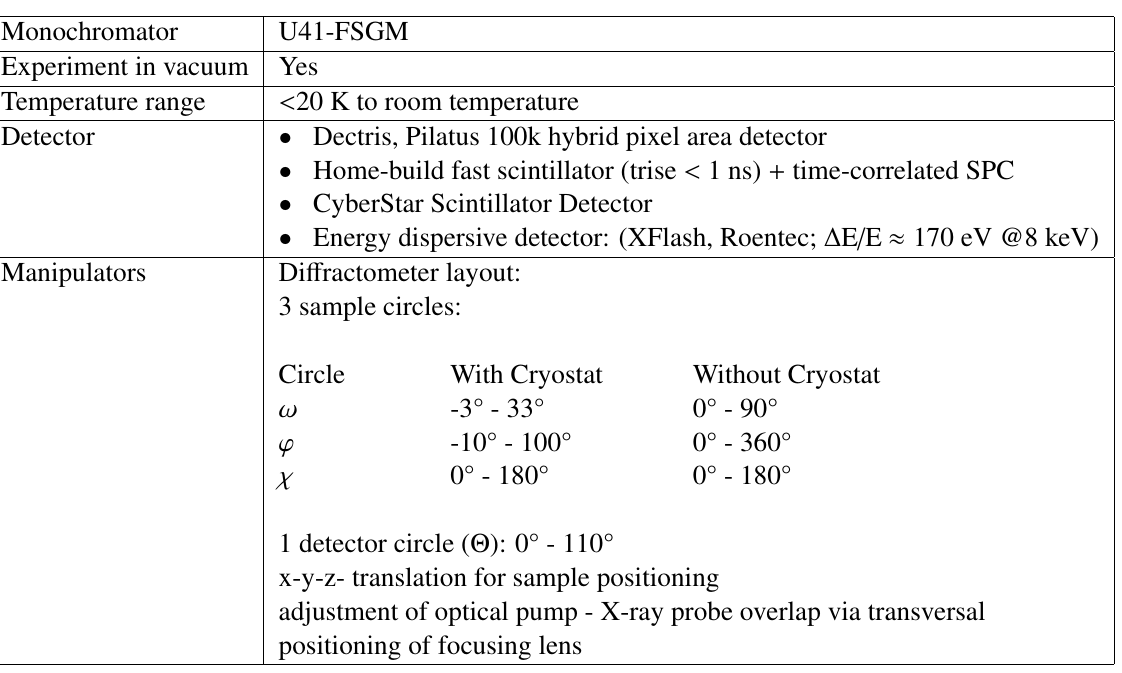
Table 2: Specification of the sample environment.